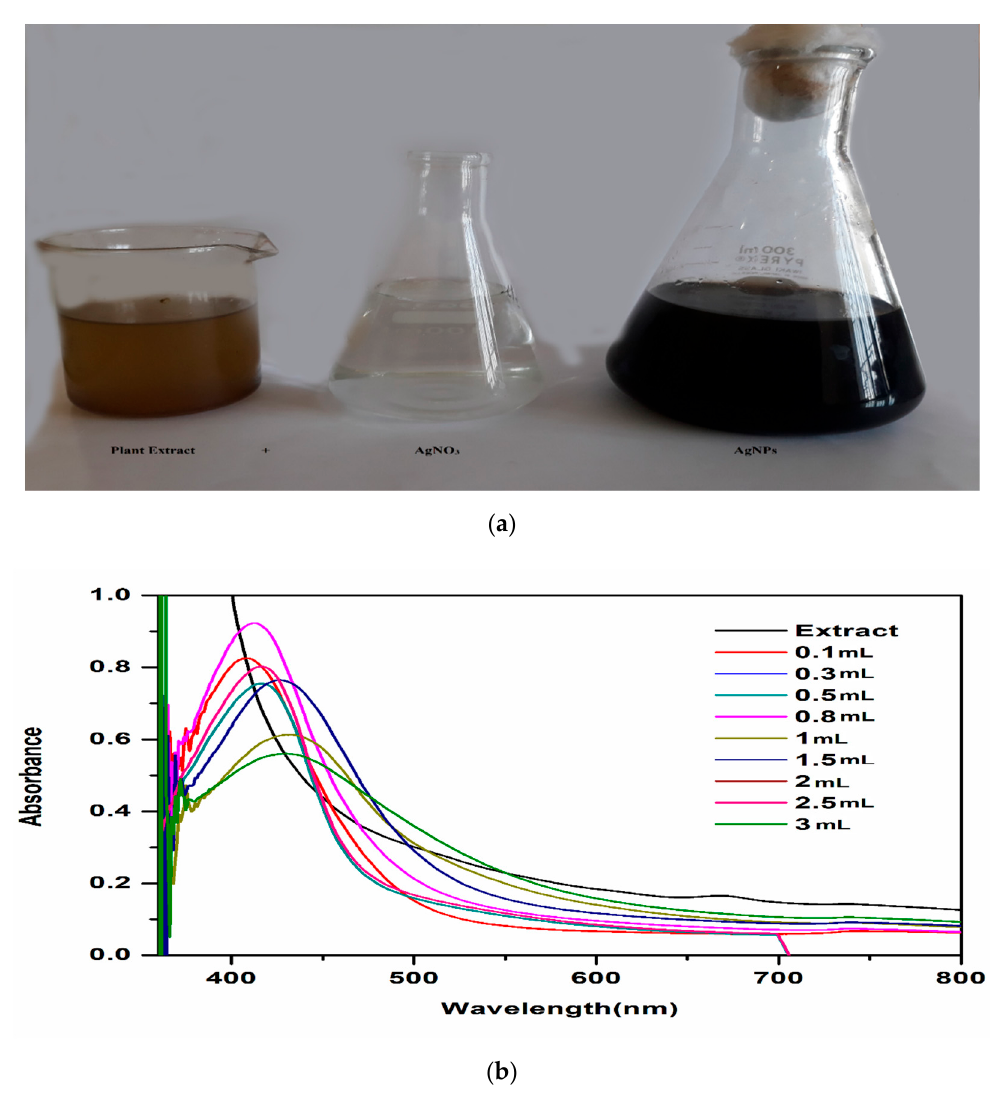
Figure 1. UV spectrum of biosynthesis of silver nanoparticles ( a , b ).